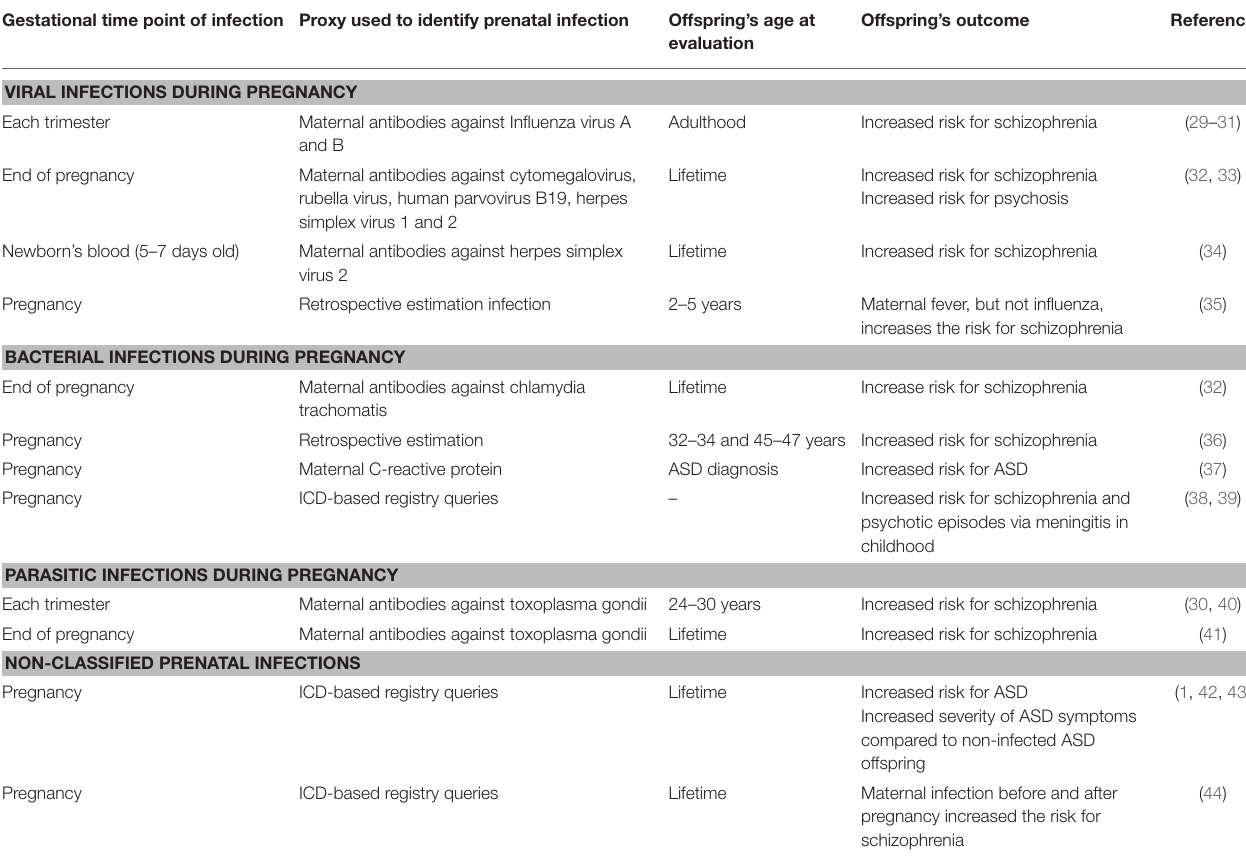
TABLE 2 | Overview of studies examining the effects prenatal infection and related maternal immune activation on offspring’s mental health in human. Gestational time point of infection Proxy used to identify prenatal